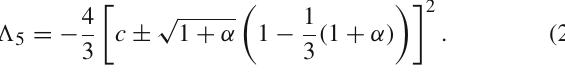
distinct asymmetric